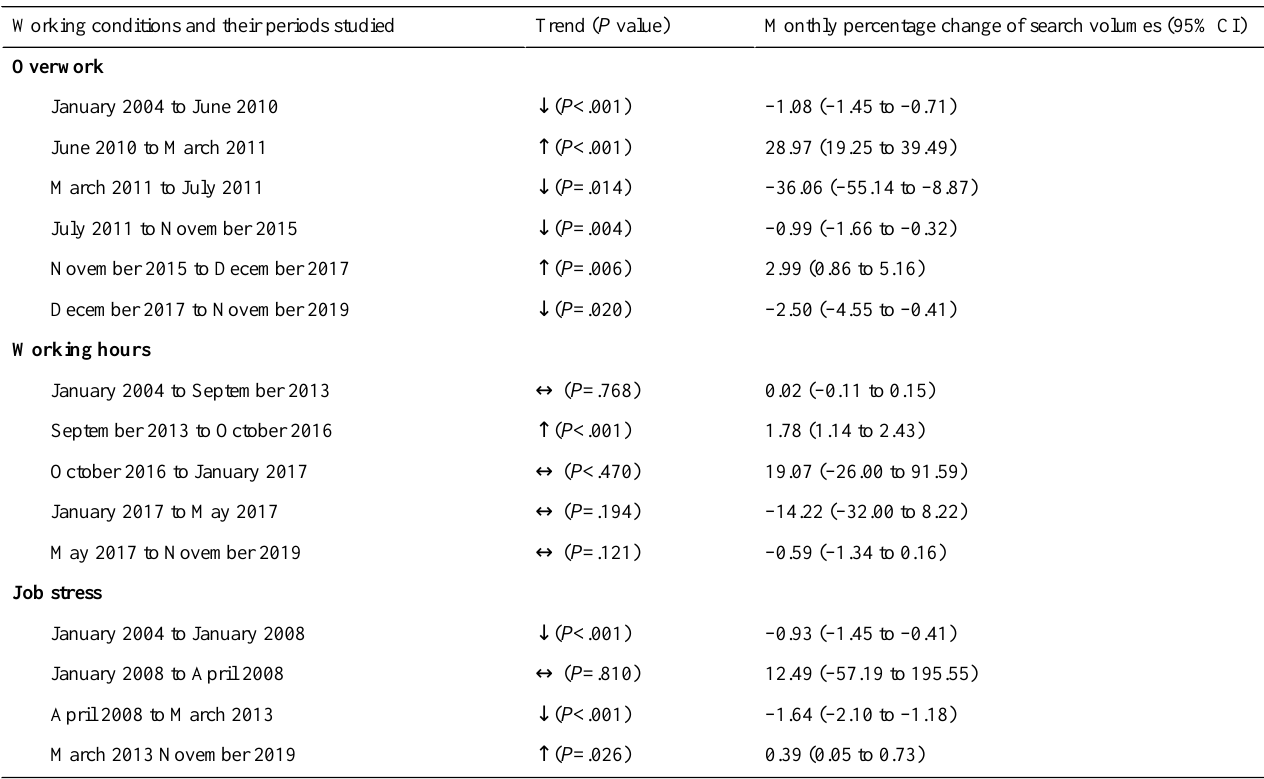
Table 1. Trends and monthly percentage change of search volumes for the 3 working